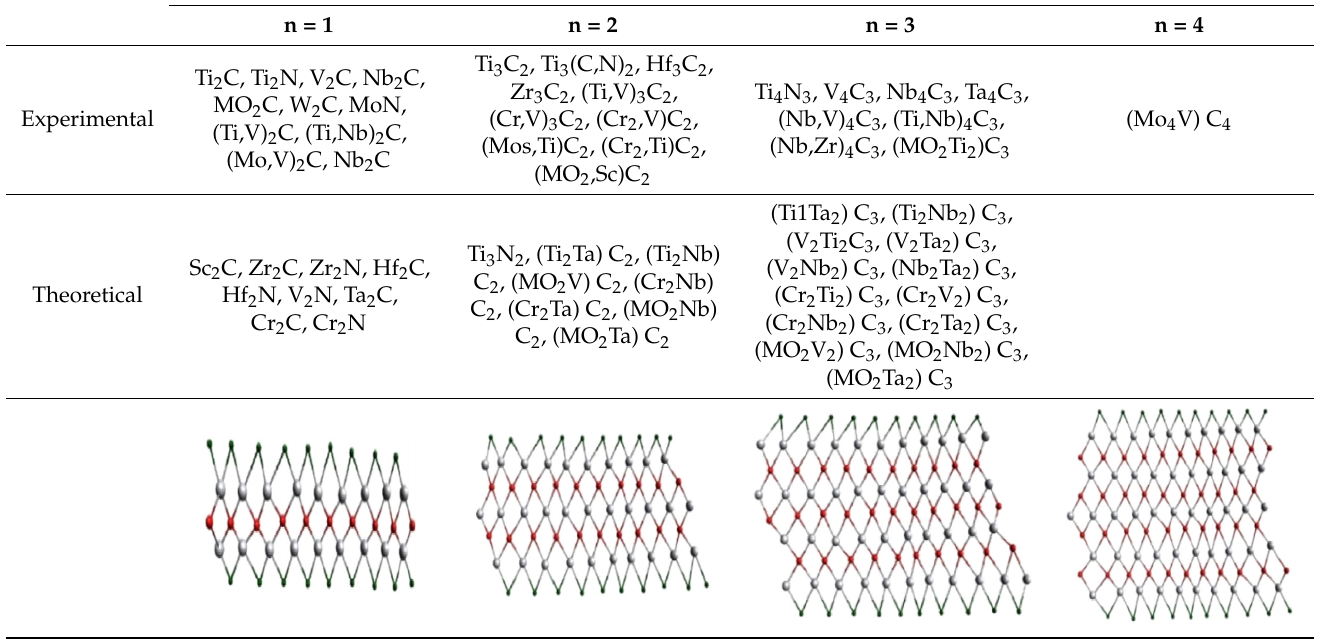
Table 1. MXene compositions that have been successfully created in the lab with the general formula of M n+1 X n T x . M could be either a single or multiple transition element. Reproduced with permission from [18]. Copyright 2021